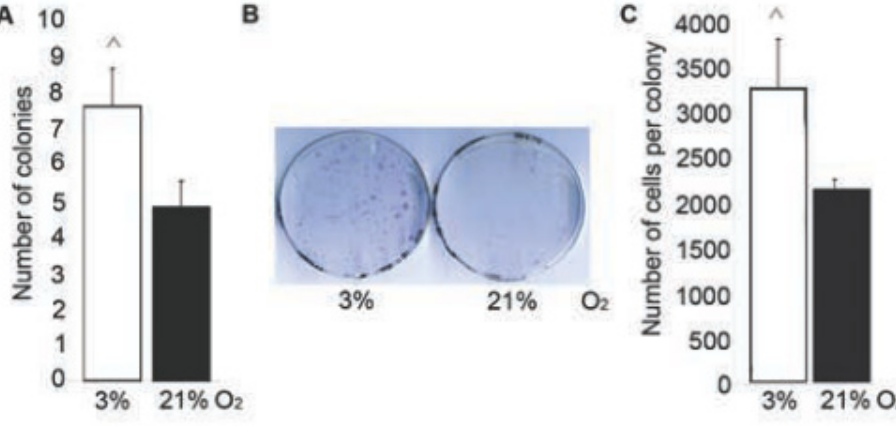
Figure 3. Effect of 3% O on MSC amount and proliferation. ( A ) Amount of colonies 2 detected in CFU-A per 10 5 of seeded cells. ( B ) Representative view of colonies in CFU-A at day 7. ( C ) Average number of cells per colony in CFU-A. The difference is significant : ^, p < for cells cultured in 3% and 21% O 2